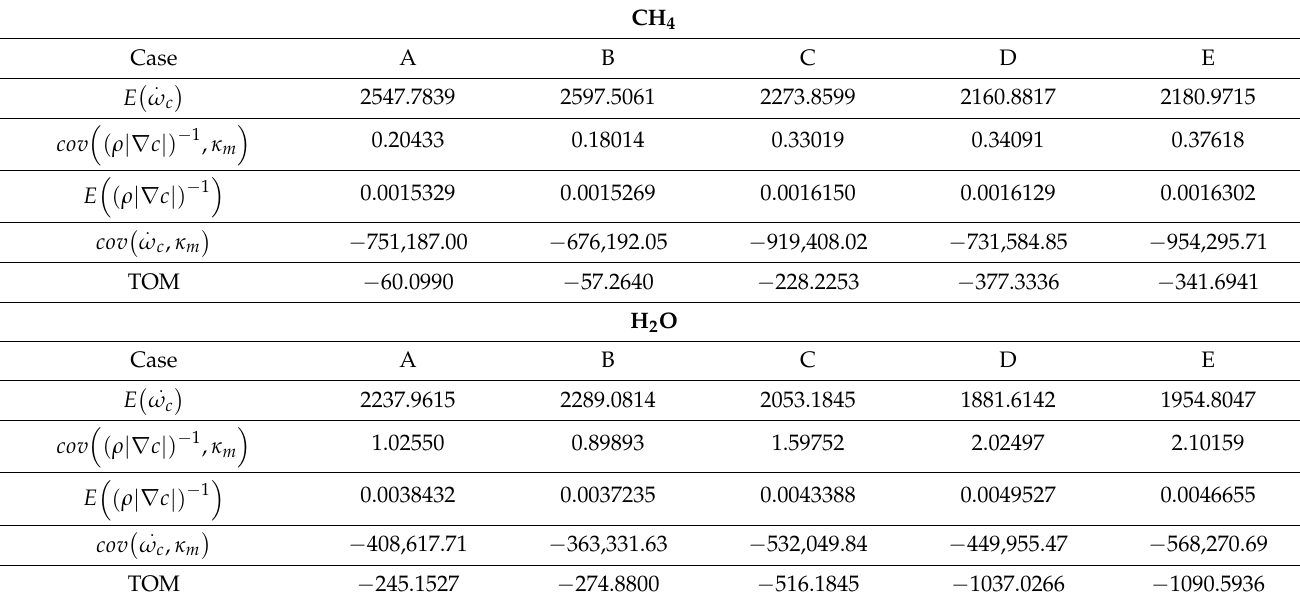
Table 14. Statistical quantities that influence the value of cov ( S r , κ m ) (see Equation (12)) for the c = 0.8 isosurfaces for all cases and reaction progress variable based on CH 4 and H 2 O ..